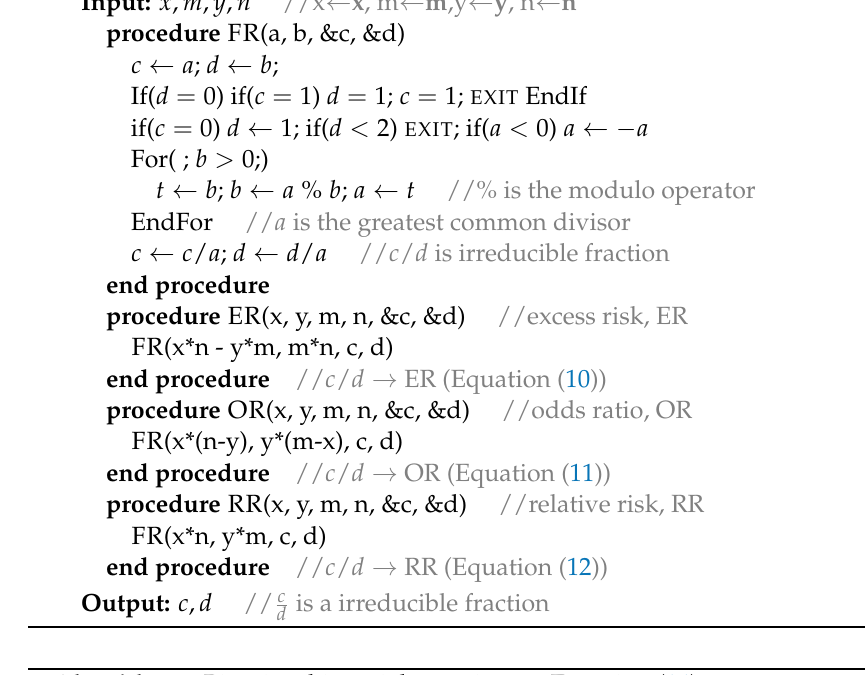
Algorithm 2: Expression for ER, OR, RR (Equations (10)–(12)) as irreducible fraction.